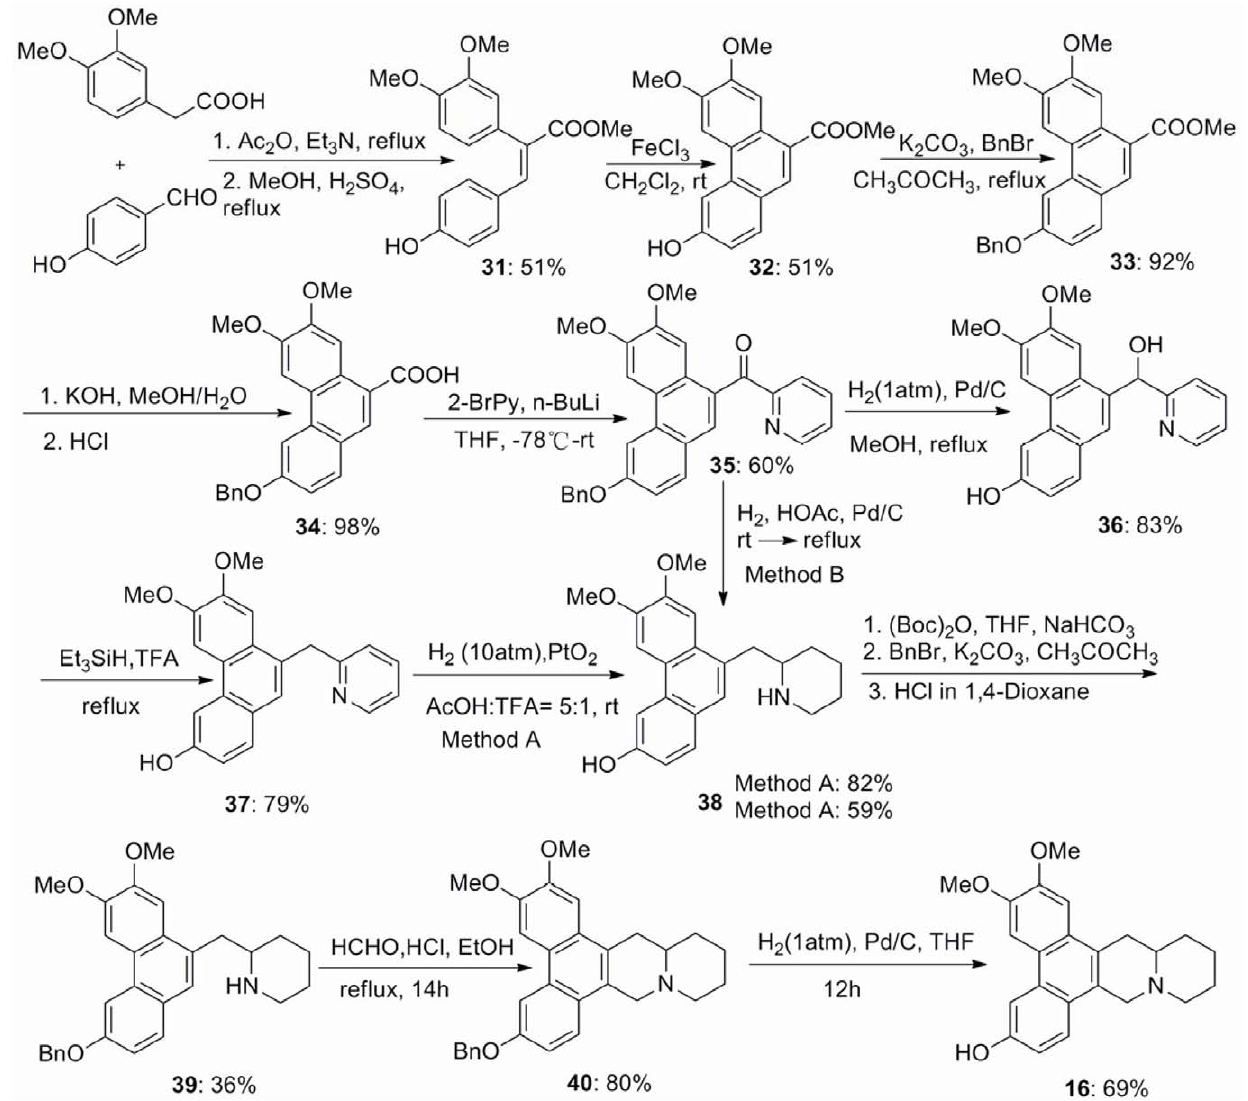
Figure 4. Synthesis of compound 16.